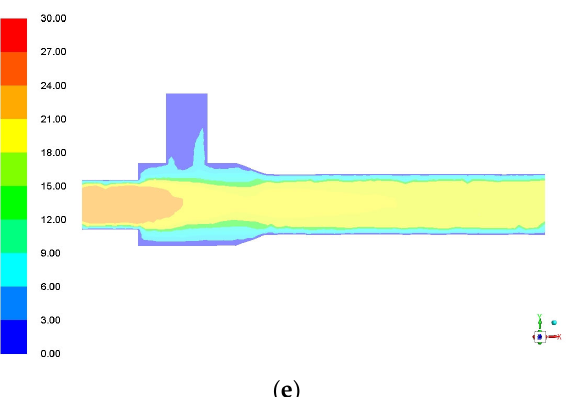
Figure 6. Variation of air fl ow fi eld in di ff erent seed-feeding angle tubes: ( a ) 30°; ( b ). 45°; ( c ) 60°; ( d ) 75°; ( e ) 90°.